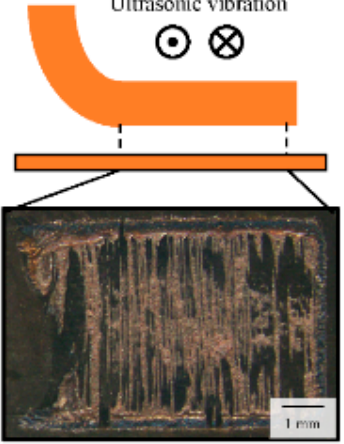
Figure 3. Stereomicroscope image of fracture surface of the C1020 joint.